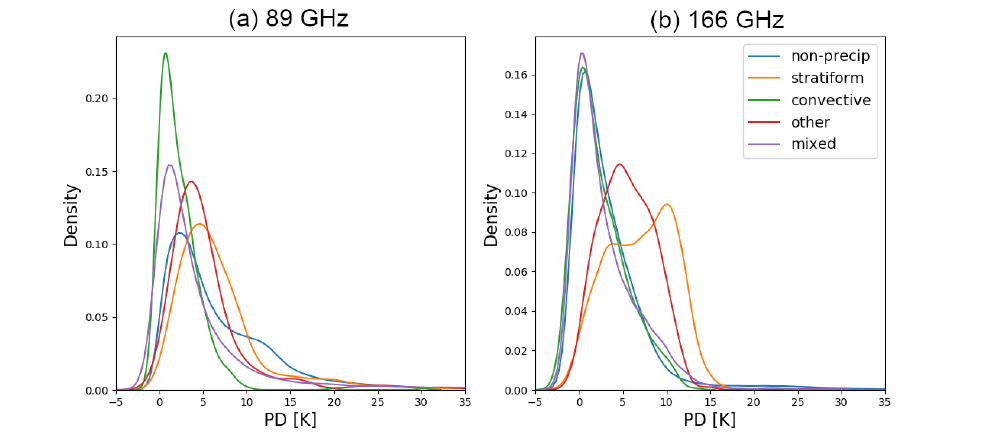
Figure 2. Density distribution of PDs by precipitation types at ( a ) 89 GHz, and ( b ) 166 GHz from one day global GMI-DPR observations on 1 January